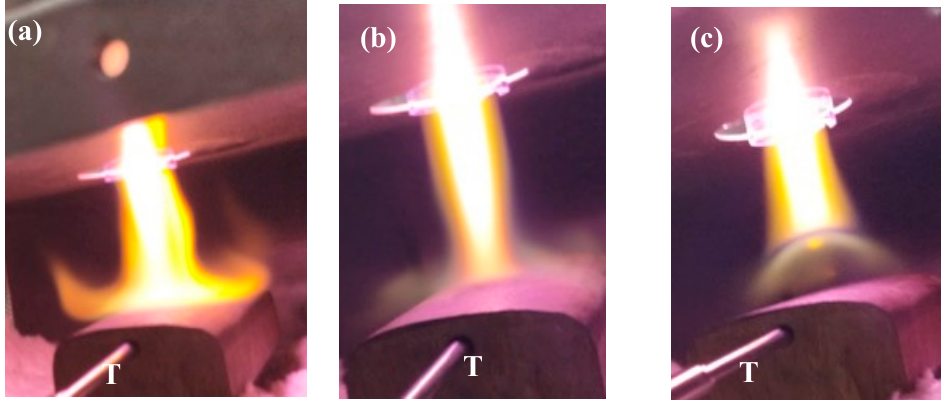
Figure 4. Plasma optimization vs. nitrogen flow rate and diameter of the dielectric tube; ( a ) 5 L/min; ( b ) 10 L/min; ( c ) 15 L/min. P forward = 2 kW, φ int = 20 mm, T = thermocouple.